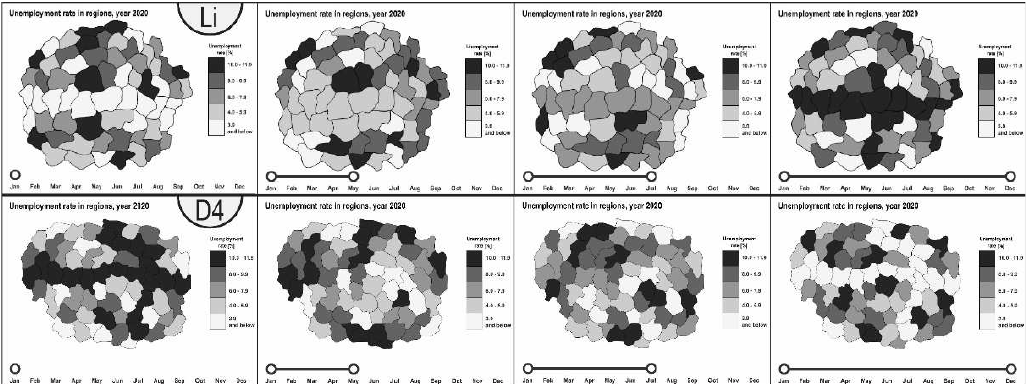
Figure 2. Selected frames of a linear and dispersed pattern. An increasing trend is in a linear pattern. The dispersed pattern has no trend. In D4, the spatial pattern is only visible at both ends of anima- tion and did not appear in other months. Li—linear increasing, D4—dispersed pattern map number 4.